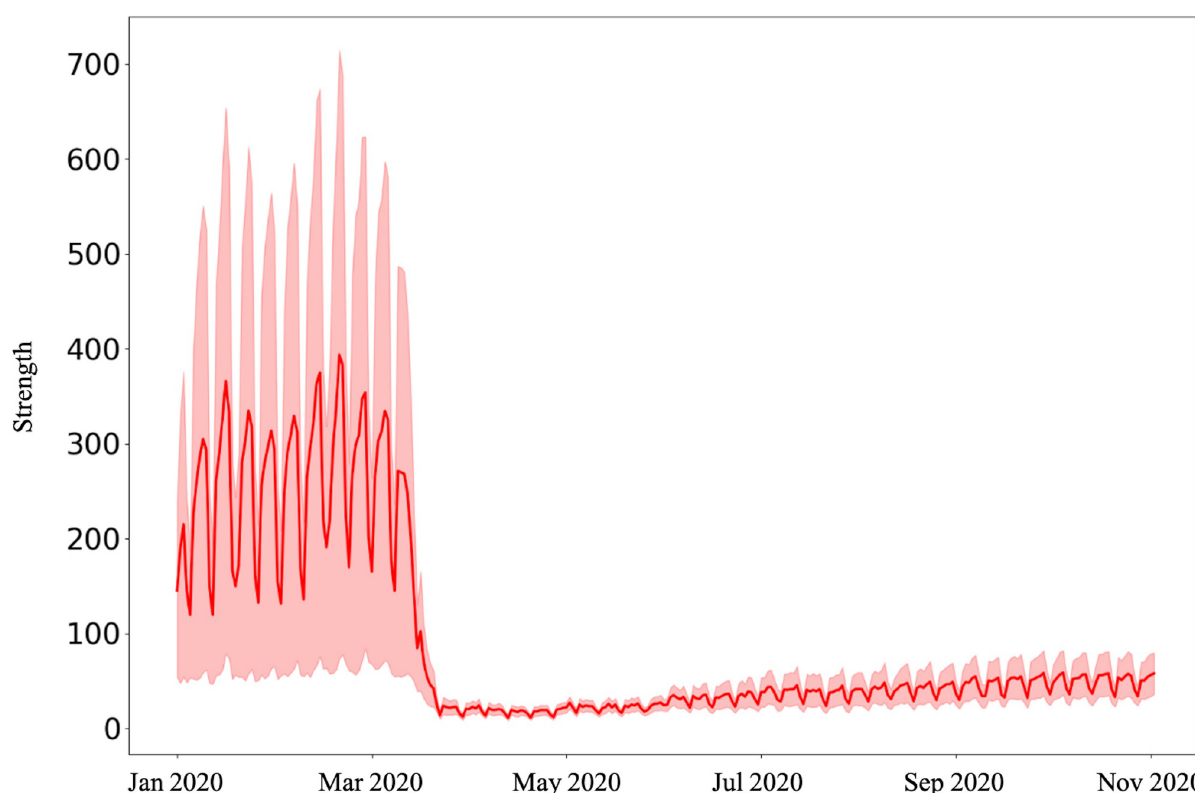
Fig 2. The average strength of community areas declines steadily from 256.65 (on March 11, 2020) (s.d. = 937.90) and stabilizes around an average of 18.31 (s.d = 22.42) (from March 26, 2020).